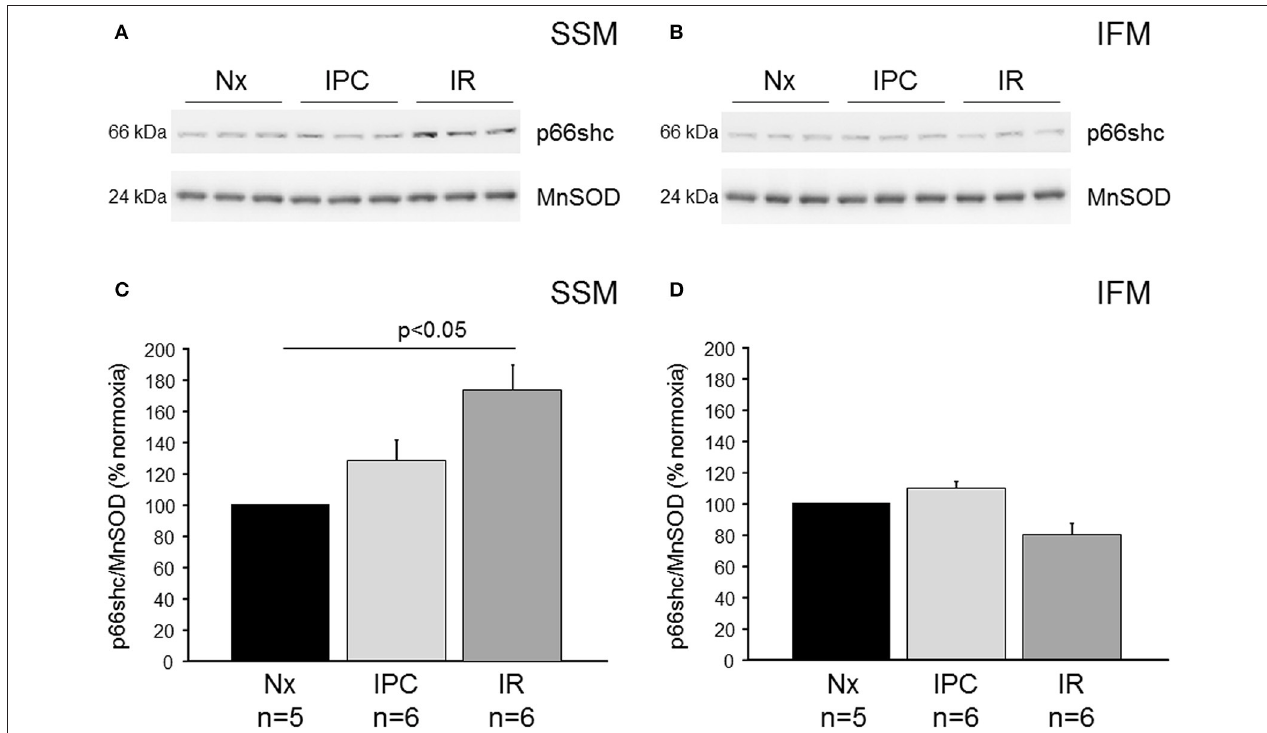
FIGURE 1 | Mitochondrial p66shc translocation following ischemia/reperfusion or ischemic preconditioning. Western blot analysis was performed for p66shc and the mitochondrial marker protein MnSOD (manganese superoxide dismutase) on SSM (A) and IFM (B) isolated from wildtype mice undergoing normoxia (Nx), ischemia/reperfusion (IR) or IR with ischemic preconditioning (IPC). Bar graphs represent the ratios of p66shc over MnSOD in SSM (C) and IFM (D) isolated after Nx, IR, or IPC.